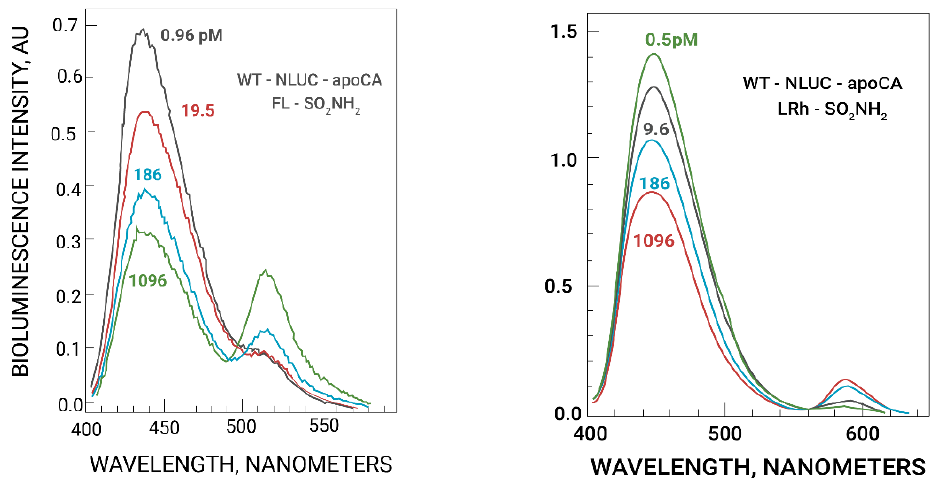
Figure 2. Zinc-dependent emission spectra of wt-NLUC-apoCA with fluorescein sulfonamide ( left panel ) or Lissamine Rhodamine sulfonamide ( right panel ). Reading from the top at 450 nm the free zinc concentrations are ( left panel ) 0.96 pM, 19.5 pM, 186 pM, and 1.096 nM; and ( right panel ) 0.5 pM, 9.6 pM, 186 pM, and 1.096 nM.